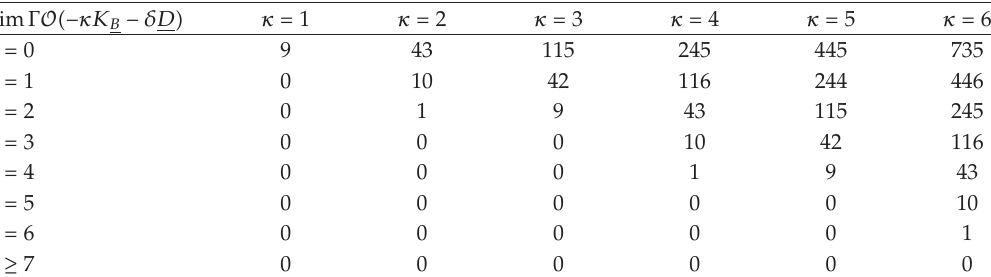
Table 2: Number of sections of O (cid:2) − κK B − δD (cid:3) .